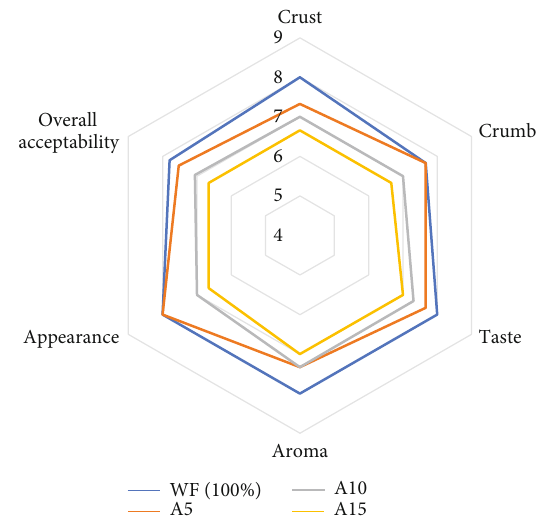
Figure 2: Sensory radar chart showing colour, texture, aroma, taste, and overall acceptability of bread substituted with various percentages of amaranth fl our (AF). A5: 5% amaranth fl our+95% wheat fl our; A10: 10% amaranth fl our+90% wheat fl our; A15: 15% amaranth fl our+85% wheat fl our. Table 10: E ff ect of substitution of amaranth fl our on texture, taste, aroma, appearance, and overall acceptability of bread. Parameter